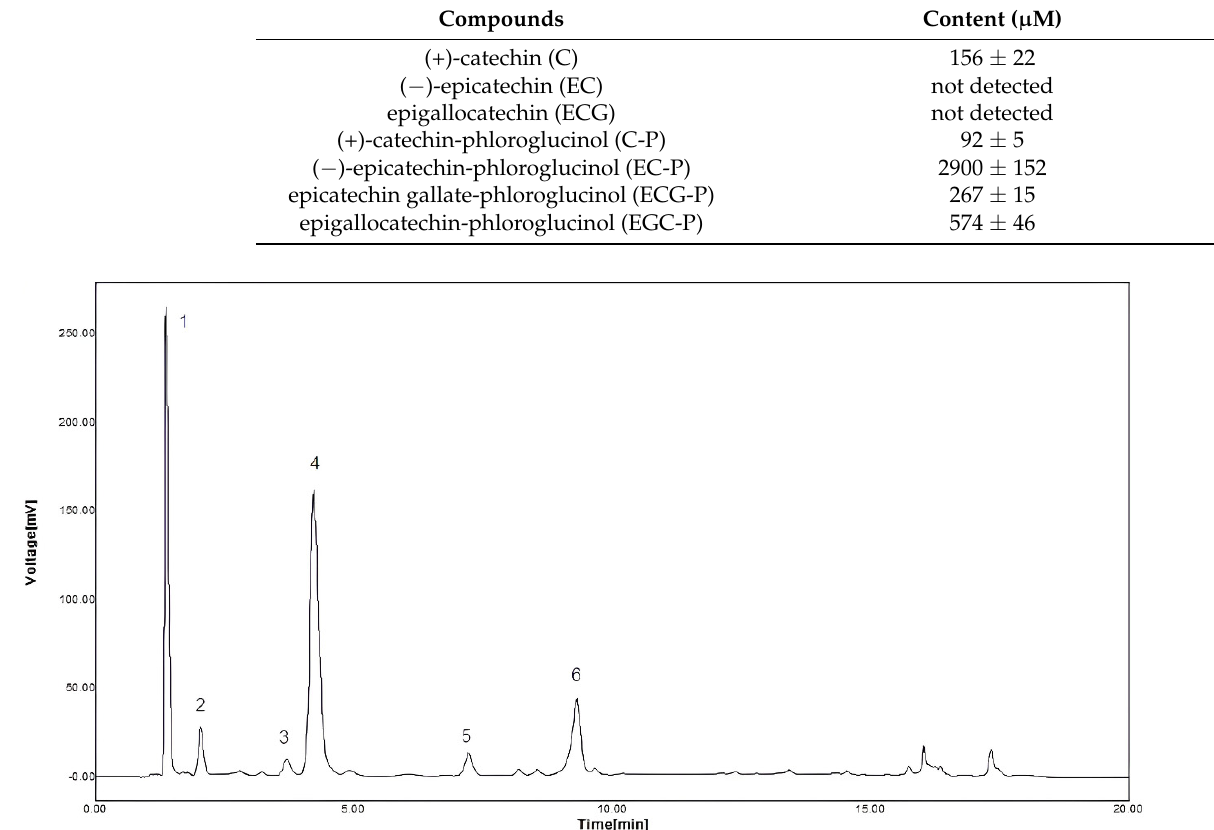
Figure 1. HPLC chromatogram of the grape skin extract after acid-catalyzed depolymerization. The main compounds identified are: (1) phloroglucinol, (2) EGC-P: (–) epigallocatechin- phloroglucinol, (3) C-P: (+)-catechin-phloroglucinol, (4) EC-P: (–)-epicatechin-phloroglucinol, (5) C: (+)-catechin, and (6) ECG-P: ( − )-epicatechin gallate phloroglucinol [11]. Reprinted from LWT - Food Science and Technology, 44, Inhibition of the angiotensin-converting enzyme by grape seed and skin proantho- cyanidins extracted from Vitis vinífera L. cv. País, Authors: Gonzalo Eriz, Verónica Sanhueza, Marlene Roeckel, Katherina Fernández with permission from Elsevier (2011).